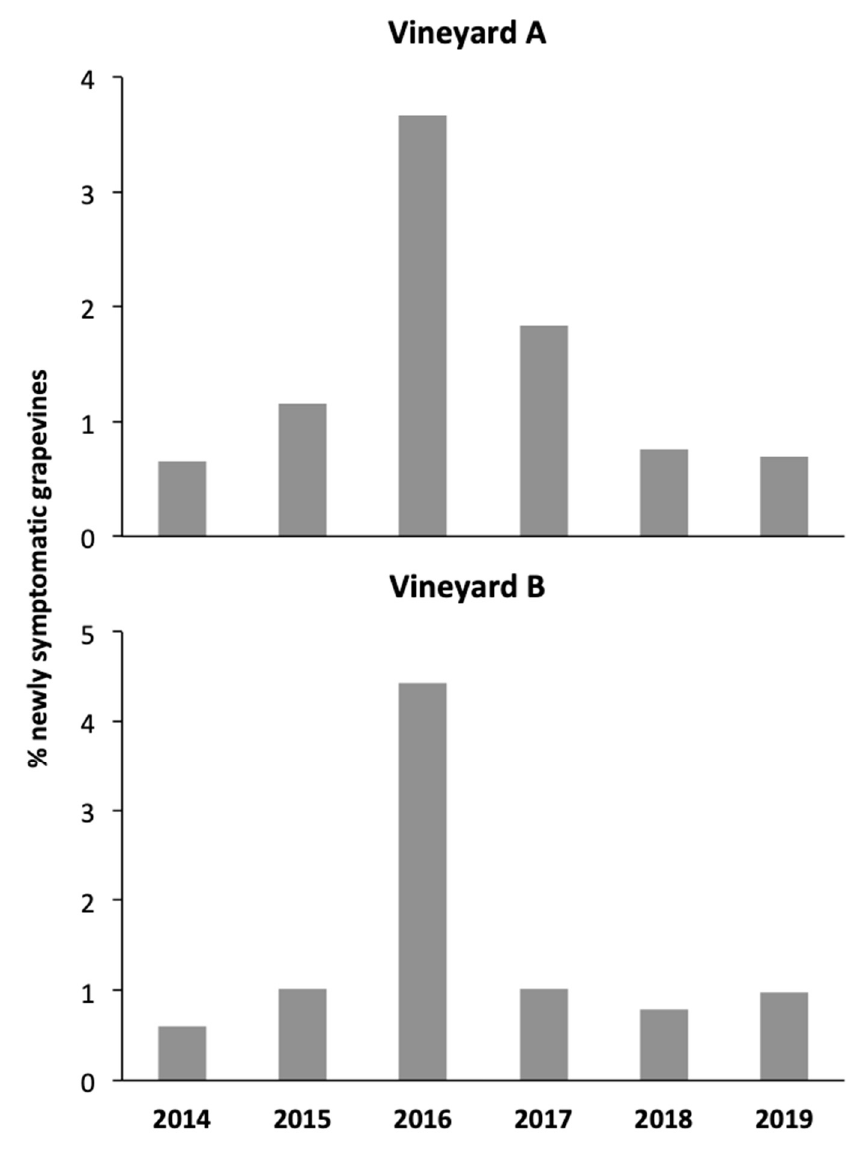
Figure 5. Newly grapevine yellows (GY) symptomatic grapevines recorded in vineyards A and B over the monitoring years.